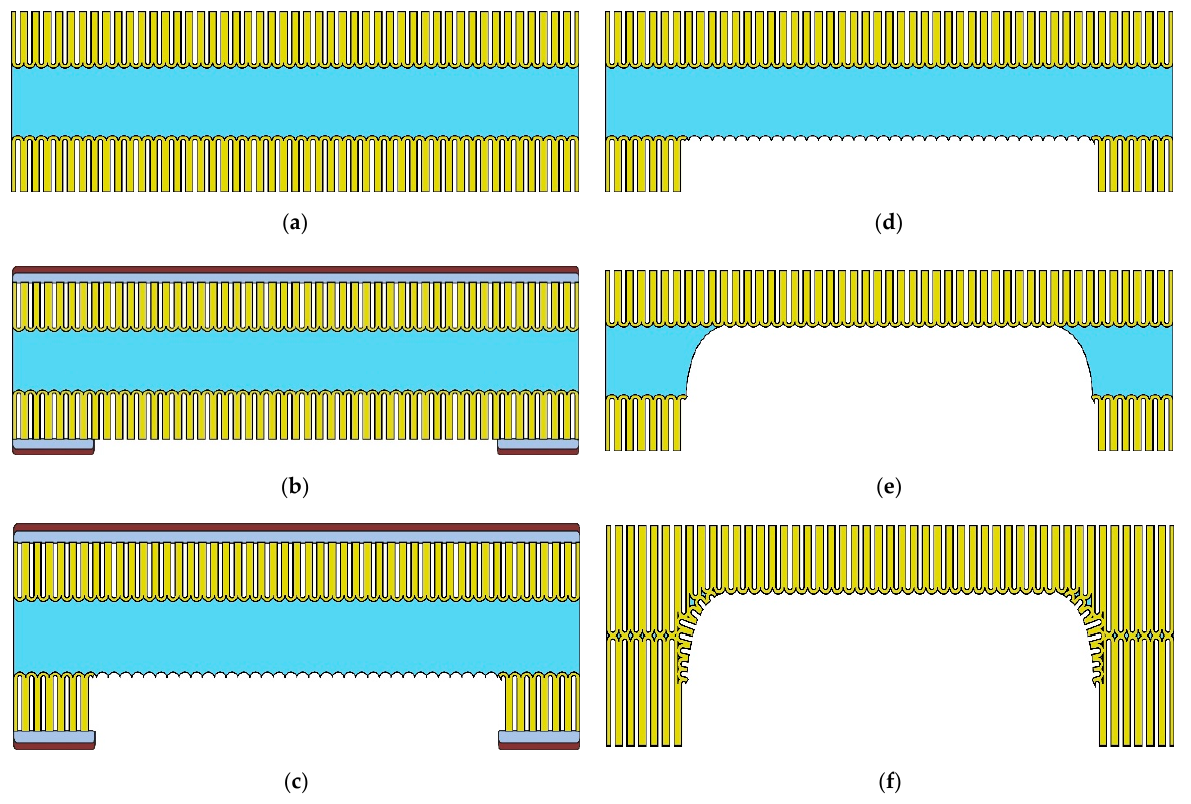
Figure 1. Schematic route for the manufacture of profiled substrates with thin membranes. ( a ) Two- sided anodization in 0.5 M oxalic acid under anodic voltage 55 V. ( b ) Coating with a protective vanadium layer and photoresistive mask, photolithography. ( c ) Selective etching of porous AA in windows of the photoresist mask. ( d ) Removing of photoresist mask. ( e ) Selective chemical etching of aluminum interlayer in the windows. ( f ) Final two-sided through anodization of profiled substrate in 0.5 M oxalic acid under anodic voltage 55 V.